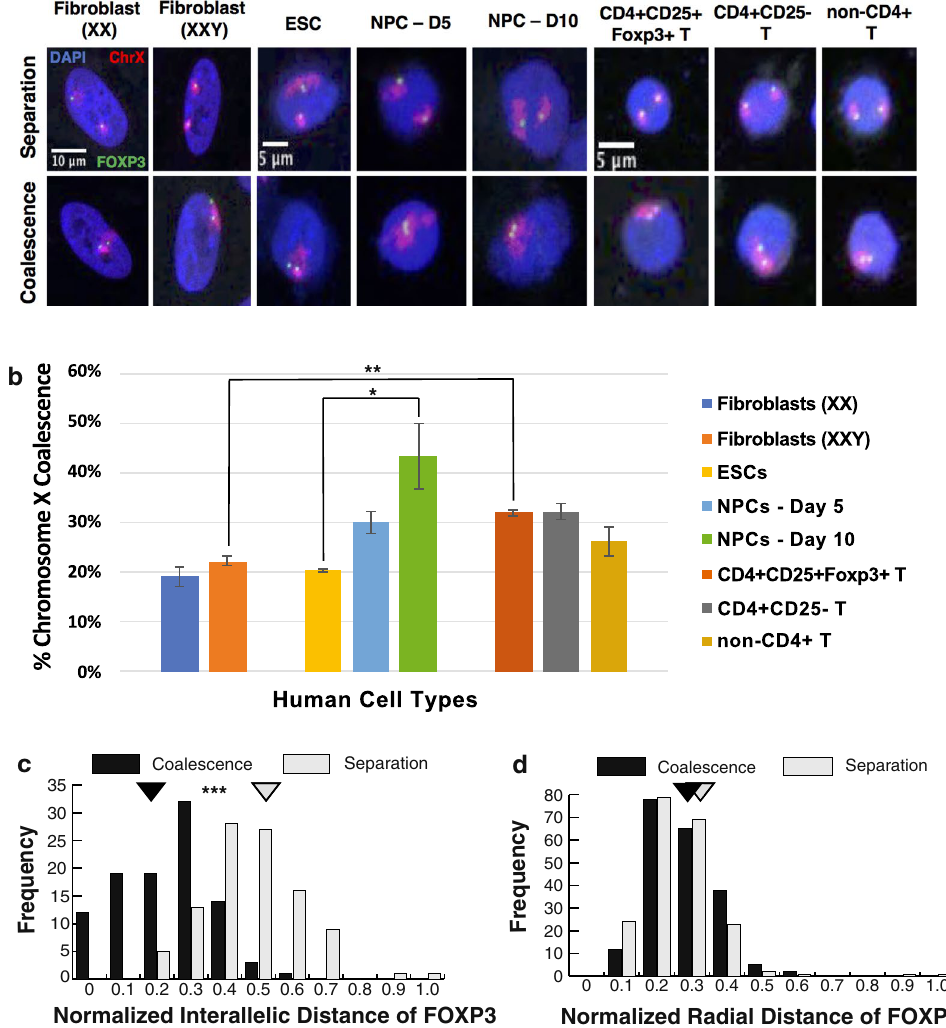
Figure 1. Chromosome X coalescence occurs at various frequencies in human cell types. ( a ) 3D DNA FISH maximum intensity projections of human nuclei labeled with DAPI (blue), chromosome X (red), and X-linked gene locus, FOXP3 (green) in various human cell types containing two X chromosomes, during X separation (upper panel) or X coalescence (lower panel). ( b ) 3D analysis of chromosome X coalescence frequency in various human cell types. Values presented as mean ± standard deviation. * P < 0.05, ** P < 0.01, Student’s t -test. Each column represents approximately 200–400 nuclei analyzed. Distribution display of normalized interallelic distances of FOXP3 ( c ) and normalized radial distances of FOXP3 ( d ) during either X coalescence or separation in human regulatory T cells (CD4 + CD25 + Foxp3 + T). Normalized distance = [interallelic: FOXP3 loci to FOXP3 loci] or [radial: FOXP3 loci to nuclear periphery] distance/d, where d = 2 × (nuclear area/ π ) 0.5 . Normalized distance ranges from 0 to 1. Mean normalized distances, triangles. * P < 0.05, ** P < 0.01, *** P < 0.001, Student’s t -test. A total of 200 FOXP3 loci were analyzed during X coalescence and X separation for interallelic and radial distances. ESC(s): embryonic stem cell(s), NPC(s): neural precursor